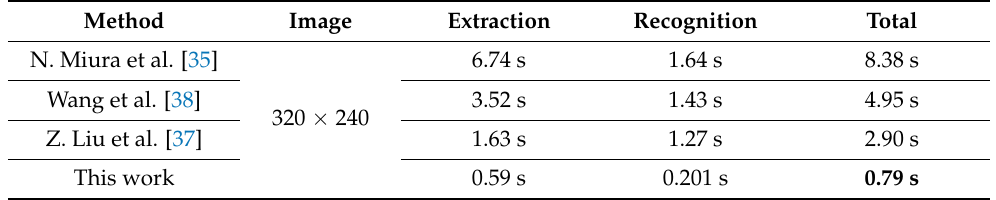
Table 6. Comparison of response